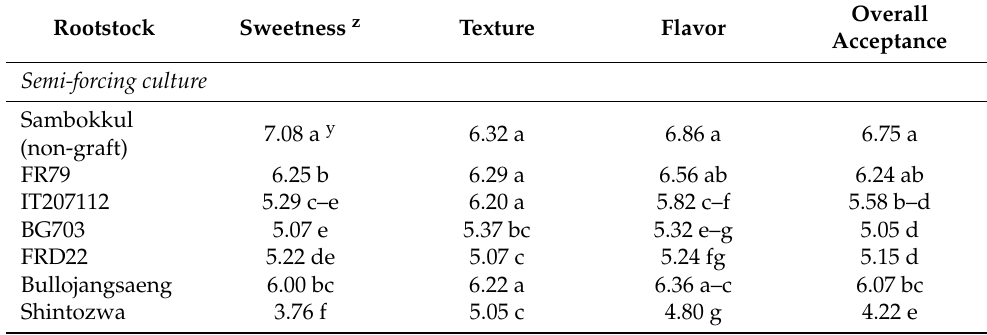
Table 5. The sensory characteristics of watermelon influenced by bottle gourd